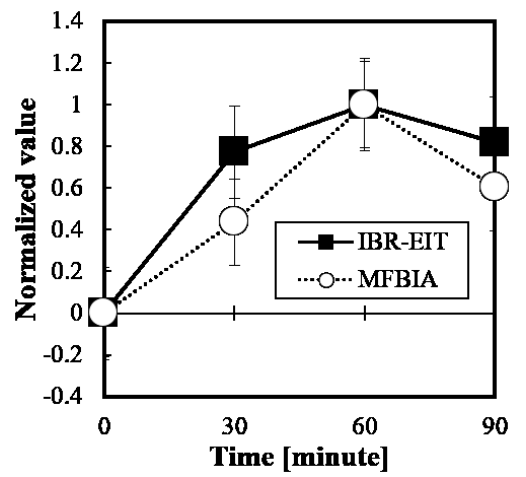
Fig. 5. The normalized temporal variation over segmental conductivity σ seg in the predicted subcutaneous layer (white part in Fig.1) and segmental extracellular water volume V seg in the right leg from image-based reference EIT (IBR-EIT) and MFBIA data,